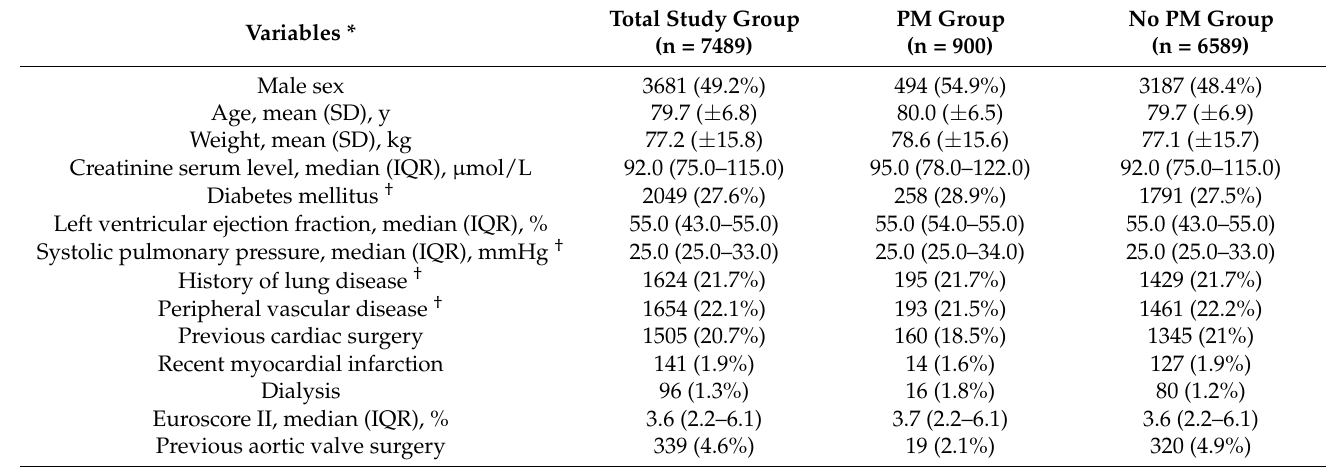
Table 1. Baseline characteristics of patients with or without a 30-day permanent pacemaker (PM) implantation after transcatheter aortic valve implantation (TAVI).